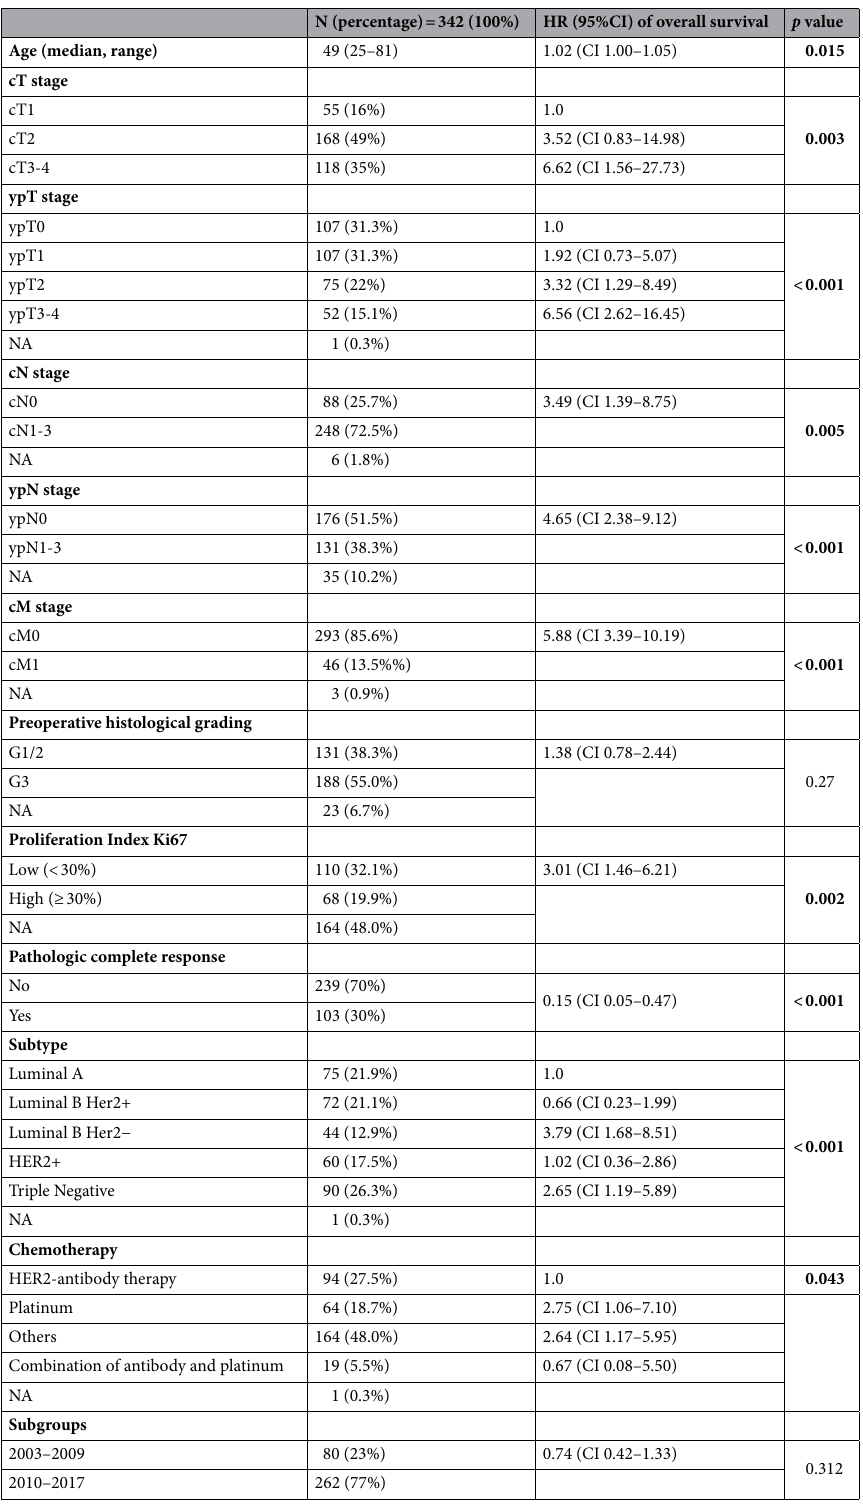
Table 2. Univariate analysis: overall survival in correlation with clinico-pathological parameters, applied chemotherapy regimens, intrinsic subtypes und subgroups in pre-therapeutic biopsy specimens. p values < 0.05 (bold labeled) are significant. NA, not